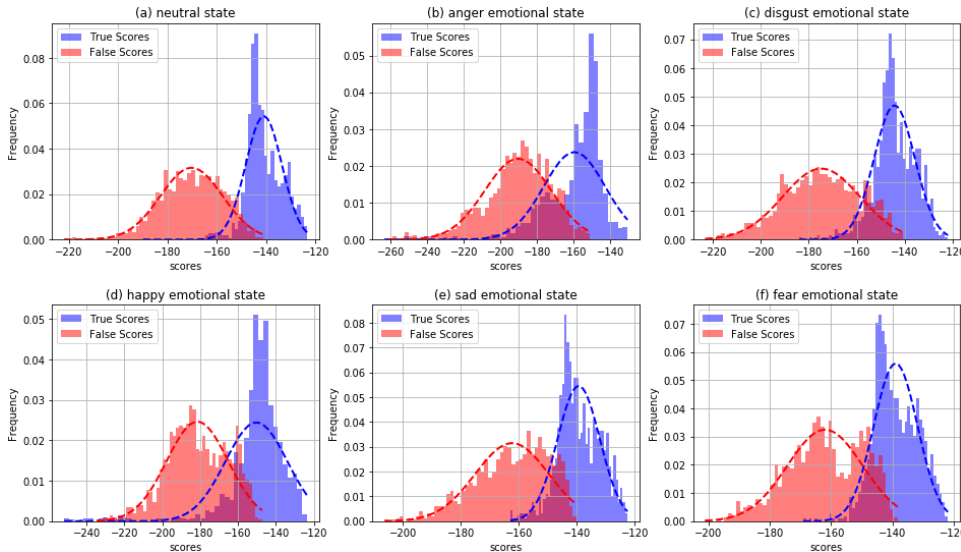
8 of 23 Figure 2. Schematic configuration of the basic structure of a node in ANN [43]. 4.5. Model Configuration and Verification The configuration of each of the GMM, SVM, KNN, and ANN models for the Emirati database are explained in the subsequent paragraphs. The Scikit-learn machine learning library in Python was utilized. 4.5.1. The GMM Model In the training phase, every speaker is characterized by a unique GMM model which is parameterized by 16 Gaussian mixture components, each having its diagonal covari- ance matrix with 200 iterations of the EM algorithm. For the Emirati database, each model is obtained using the first 5 sentences. Each speaker repeats each sentence 9 times with